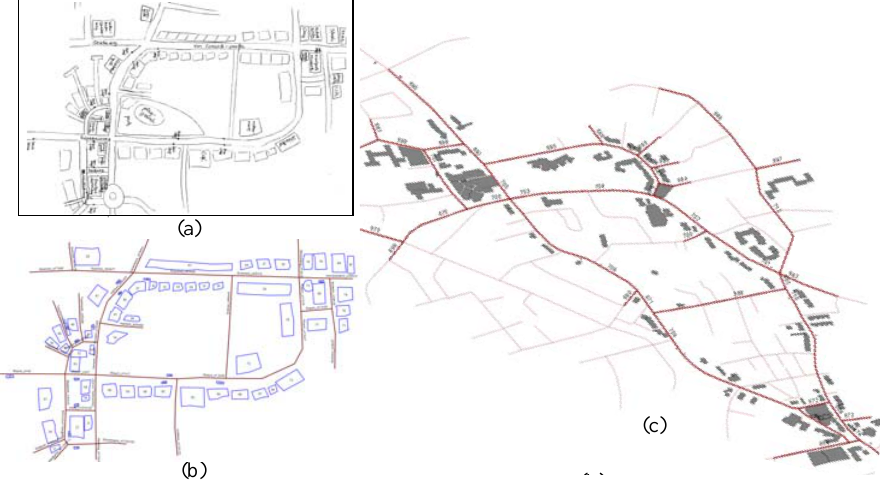
Figure 2: (a) The drawn sketch map of a region in Münster, Germany, (b) the extracted landmarks and street segments, and (c) the corresponding geo-referenced